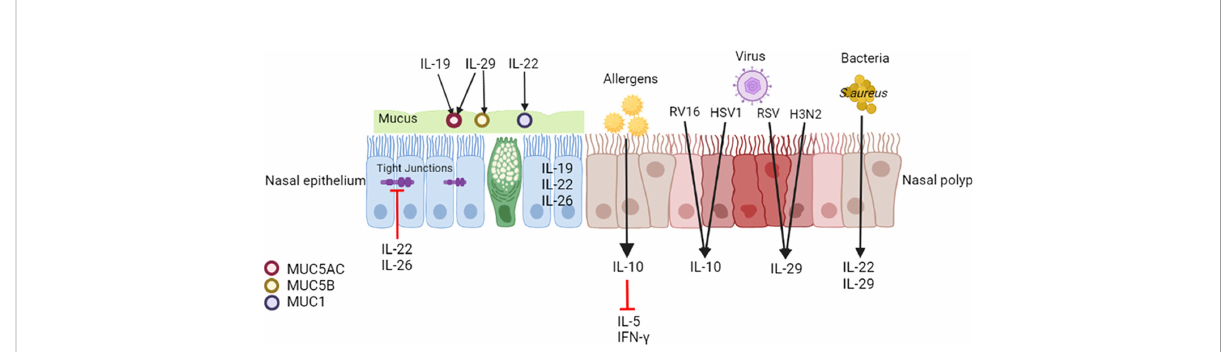
FIGURE 2 Effects of IL-10 family cytokines on CRSwNP. IL-19, IL-22 and IL-26 are expressed in the nasal epithelium. IL-22 and IL-26 disrupt the epithelial barrier of nasal epithelial cells from patients with CRS. IL-19 upregulates MUC5AC expression in the epithelium in CRS, and IL-29 upregulates MUC5AC and MUC5B synthesis in the healthy nasal mucosa. IL-22 enhances MUC1 in nasal polyp cells. Upon encountering with inhaled allergens, epithelial cells may release IL-10 and consecutively decrease allergen-induced IL-5 and IFN- g production in nasal polyps. Viral and bacterial infections modulate the expression of IL-10 family members. Both RV16 and HSV1 elevate IL-10 expression in nasal polyps. Both RSV and H3N2 increase IL-29 expression in the nasal epithelium of CRS. SEB induces IL-22 production, and S. aureus infection increases IL-29 expression in nasal polyps. MUC, mucin; NP, nasal polyp; SEB, staphylococcal enterotoxin